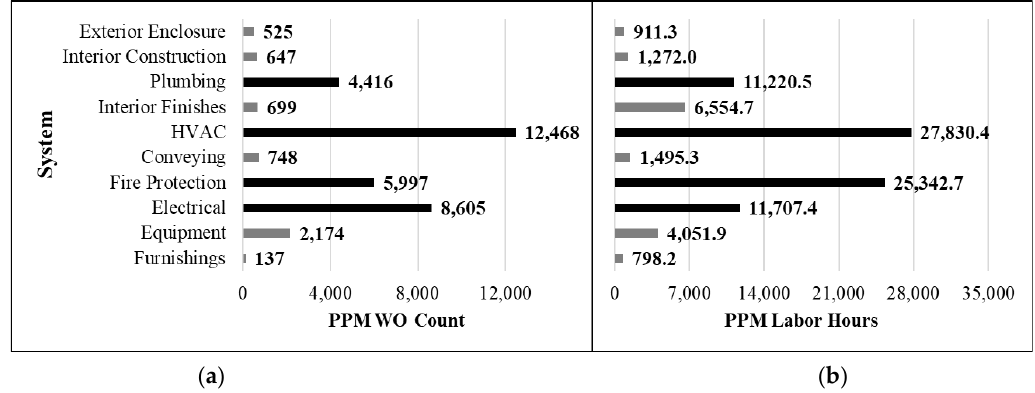
Figure 9. System-level comparison of the PPM: ( a ) Work Order Counts; ( b ) Labor Hours.